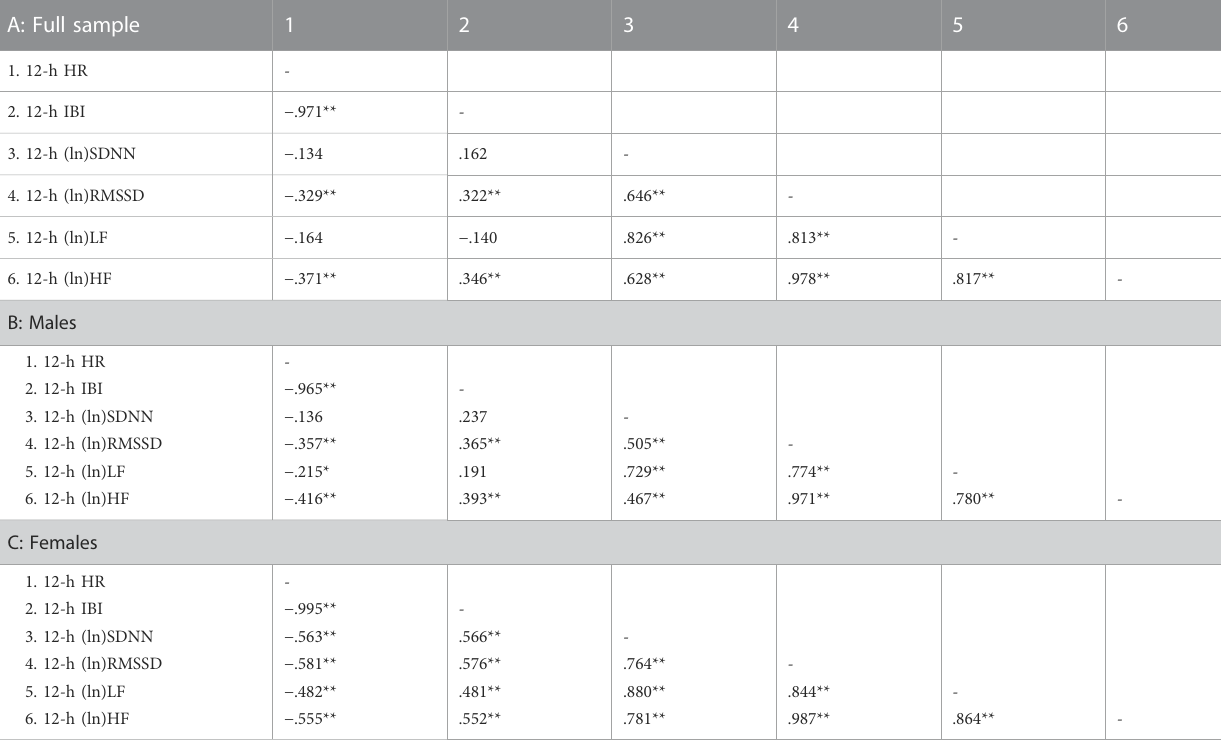
TABLE 4 Correlation coef fi cients in the full sample and strati fi ed by sex for 12-h values of cardiac chronotropy and heart rate variability during the dark phase of the daily cycle. A: Full sample